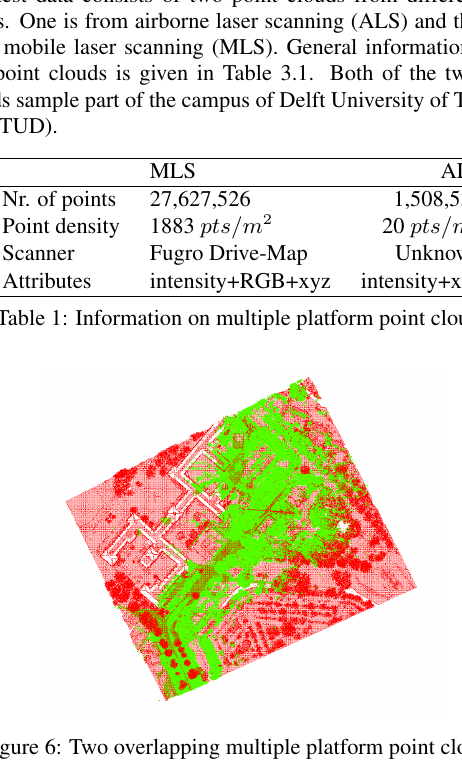
Figure 6: Two overlapping multiple platform point